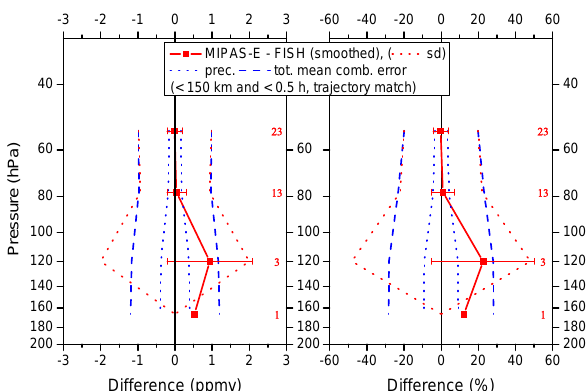
Fig. 6. Mean differences from a trajectory match statistics between H 2 O profiles measured by MIPAS-E and balloon-borne FISH on 6 March 2003 and 9 June 2003 together with combined errors, as well as standard deviation and the standard error of the mean, plotted as error bars. Annotation as per Fig. 2.